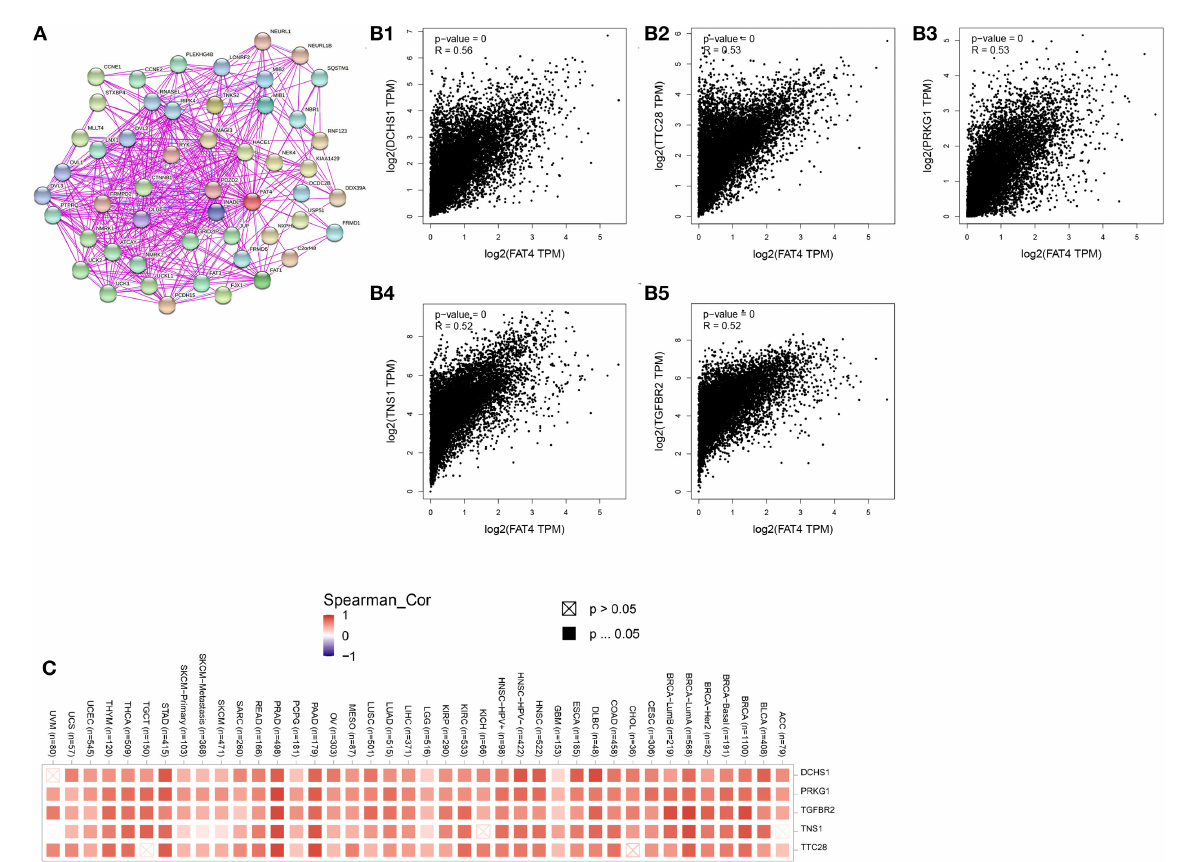
FIGURE7 FAT4-Related Gene Analysis. (A) FAT4-binding proteins. (B) The correlation between FAT4 and top 5 FAT4-related targeted genes. (C) The expression of top 5 FAT4-related targeted genes in